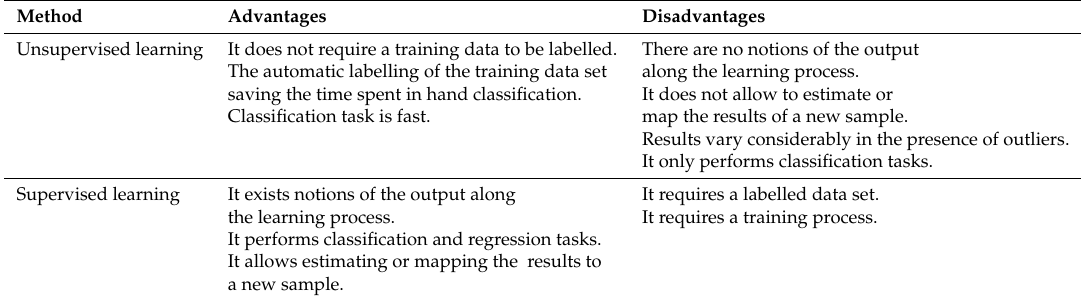
Table 4. Advantages and disadvantages of unsupervised learning and supervised learning.